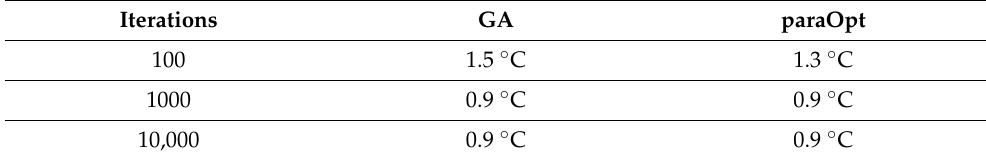
Figure 19. Simulation result after optimization with pattern2 . Table 10. Temperature for pattern1 of CFD model .